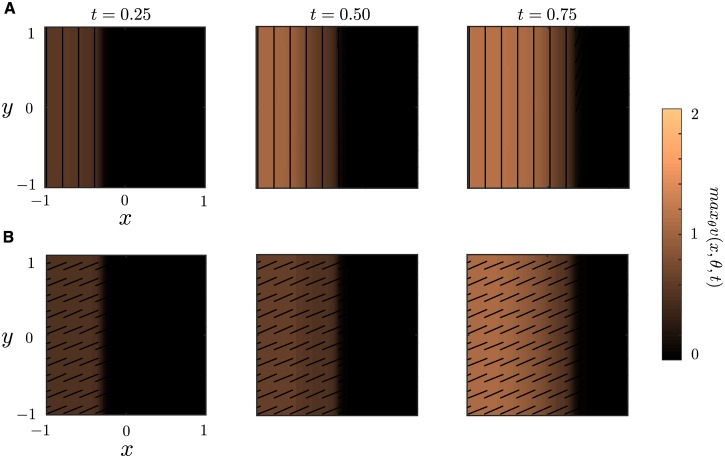
Two-dimensional plane waves.Numerical simulation of Eqs (4a) and (4b) for (A) anisotropic connection A(θ) = 1 + cos(2θ) and (B) isotropic connections A ≡ 1. All parameter values are the same as in Fig 6 and we take x
0 = −0.5. All weight functions are the 2D analogs of the functions used for 1D.